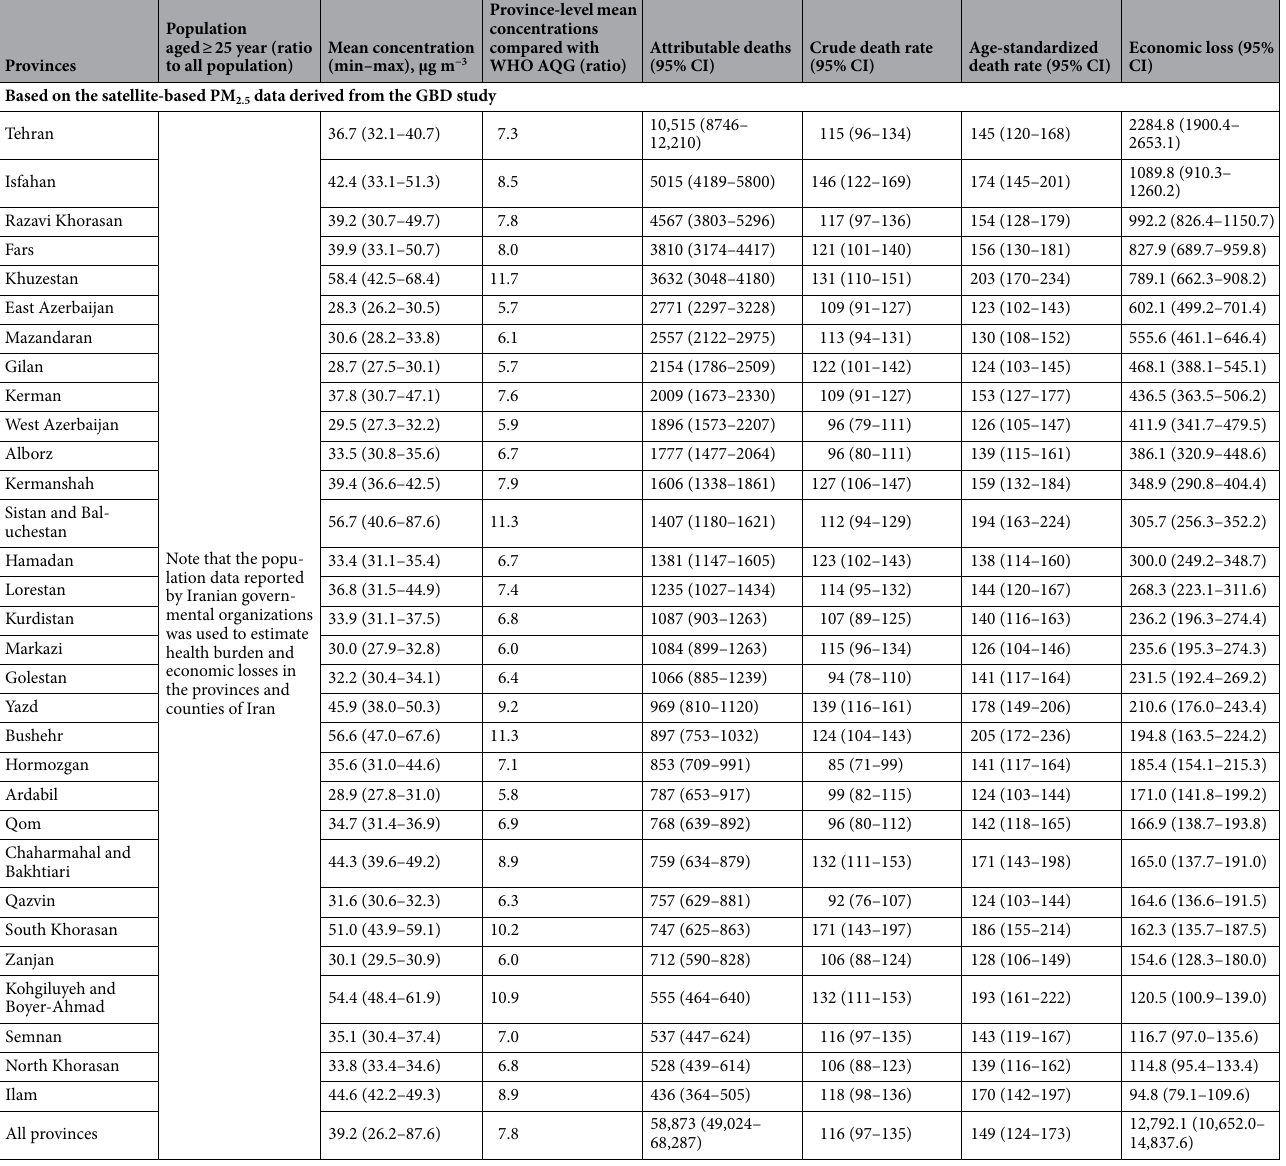
Table 2. Number of all-cause mortality, crude and age-standardized death rate (for age-group ≥ 25 years old) and economic loss (× 10 6 USD) in the 31 provinces of Iran due to PM 2·5 in 2018 based on both ground- monitored and satellite-based PM 2.5